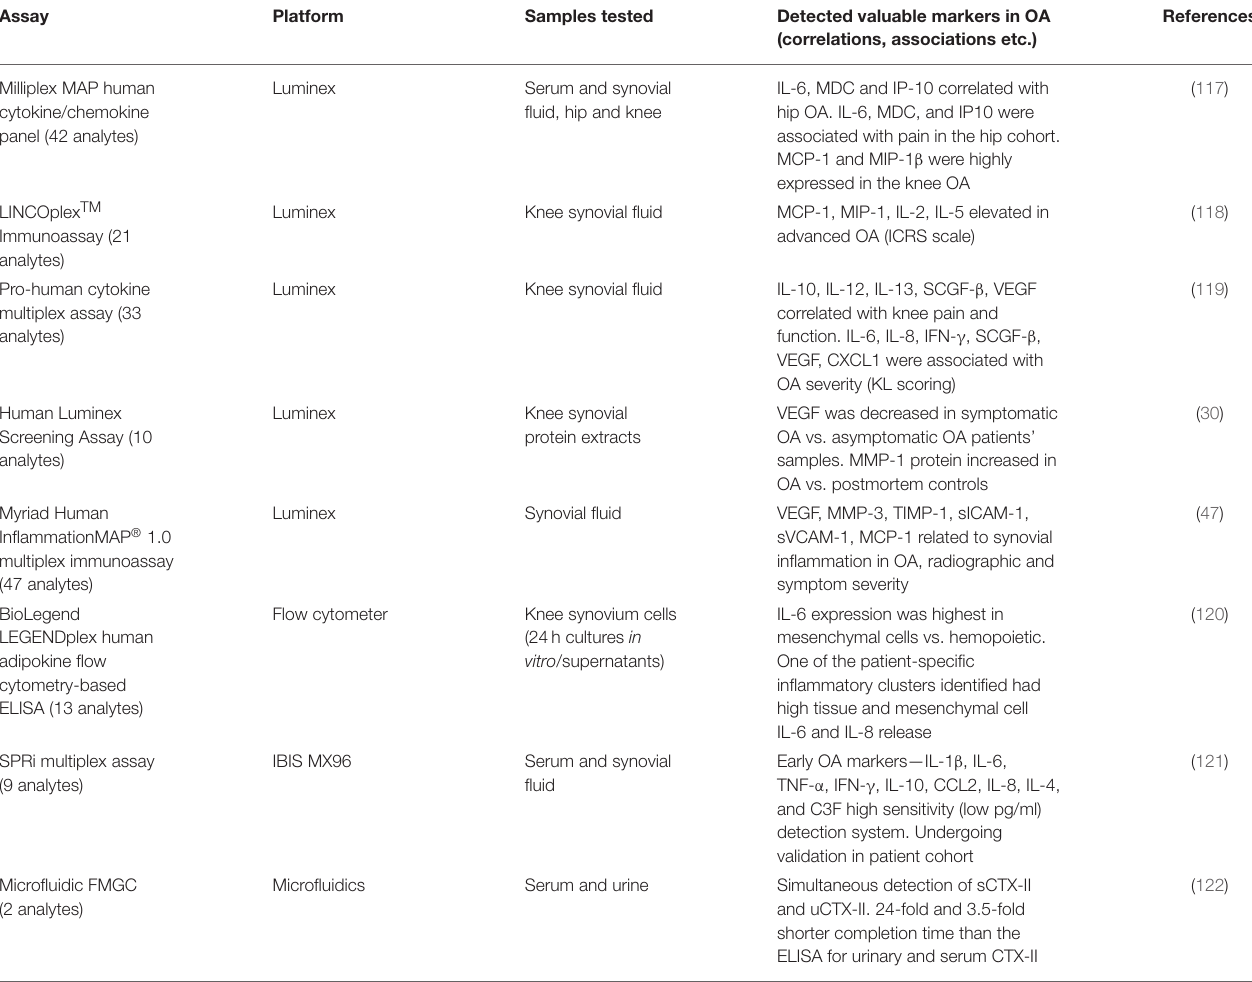
TABLE 1 | Multiplex assays-based studies in OA. Assay Platform Samples tested Detected valuable markers in OA